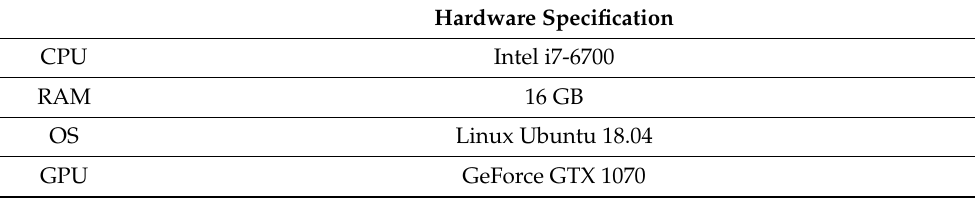
Table 2. Performance Evaluation Environment.